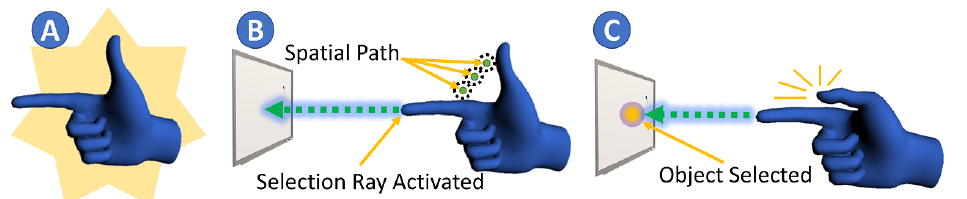
Figure 5. Exemplary implementation of a selection tool using the framework. A recognized static gesture ( A ) activates a visible ray and a dynamic gesture ( B ). If the dynamic gesture is performed by moving the thumbs down, an object is selected that intersects the ray ( C